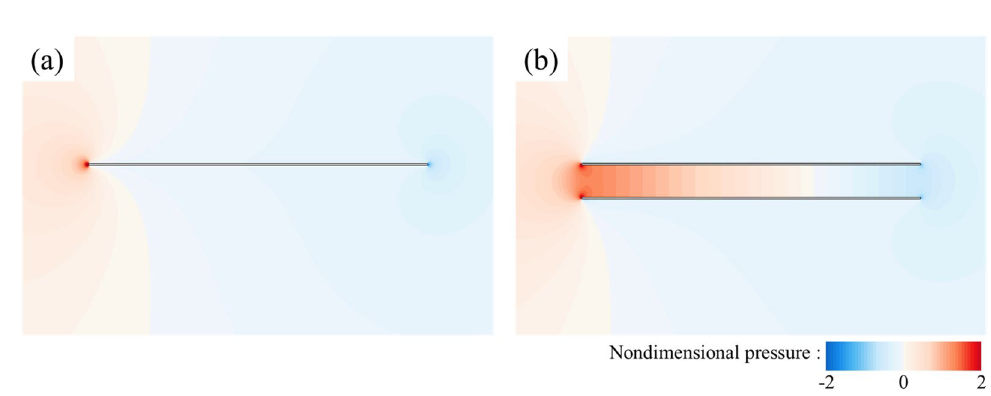
Figure 6. Pressure contour plots of ( a ) a single flat-plate wing and ( b ) two flat-plate